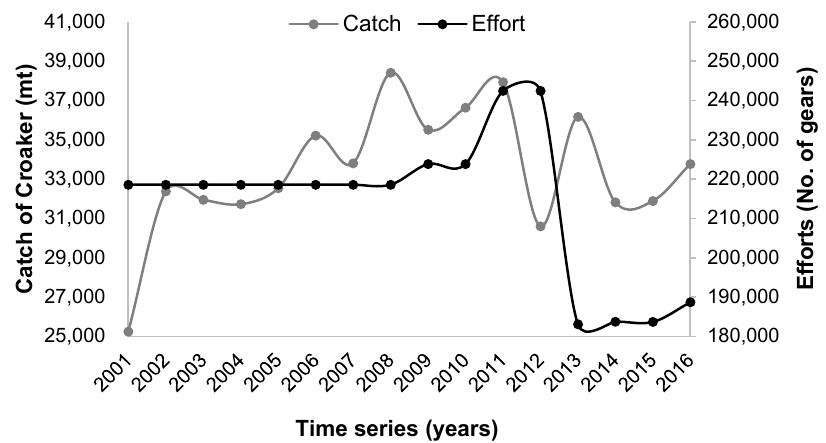
Figure 2. Schematic illustration of the time series (2001–2016) of catch and effort data of croaker from the BoB, Bangladesh.